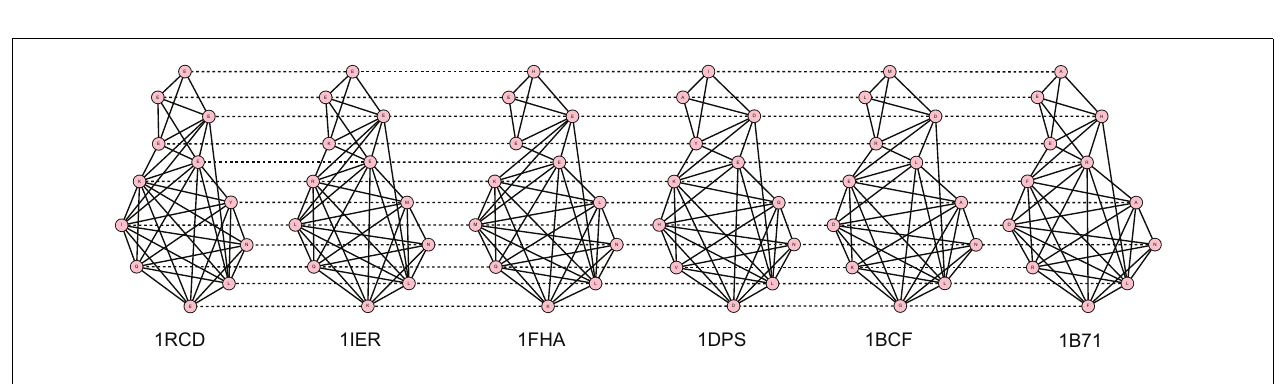
FIGURE 3 | Best alignment of the 6 Ferritin contact maps with W =